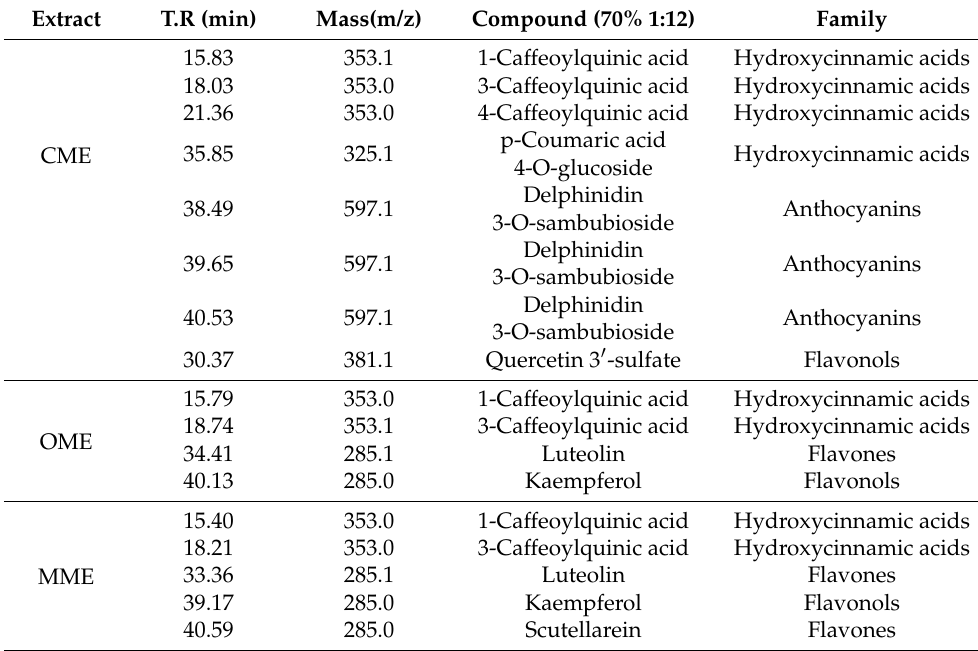
Table 1. Composition of the Phoradendron sp. extract on different hosts.